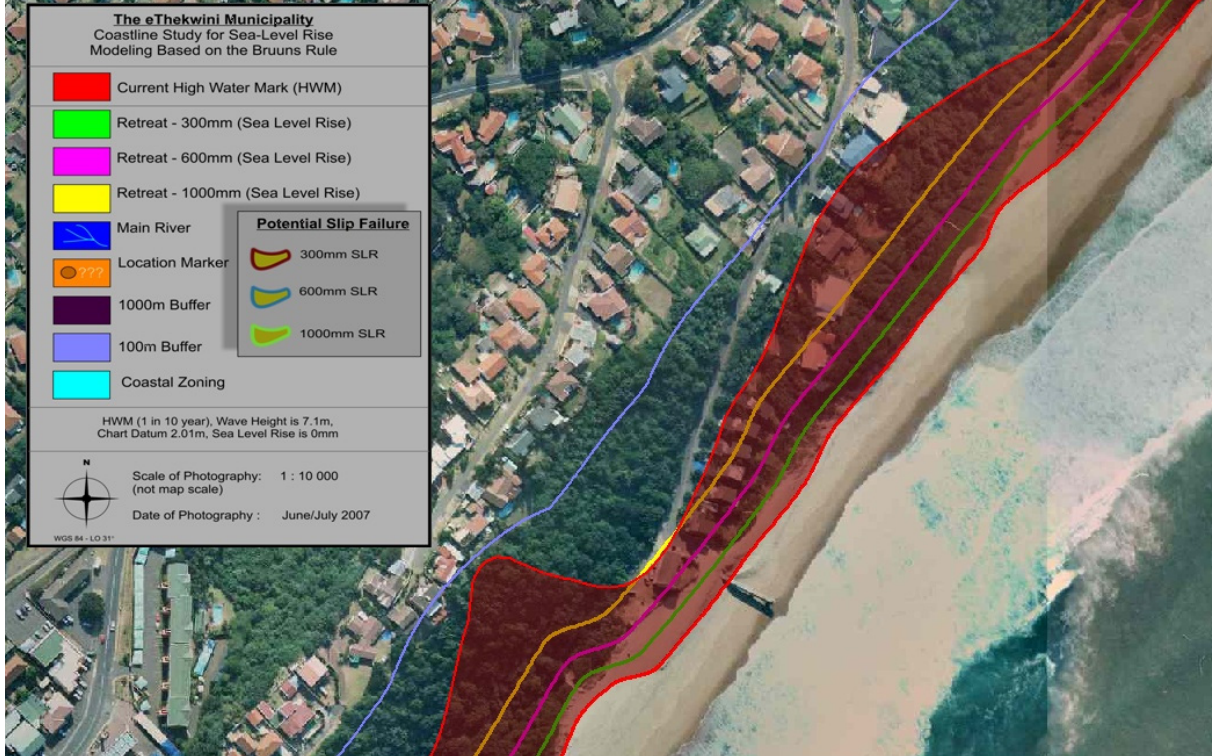
Figure 8. Slope failure of dunes with 1000 mm of sea level rise and loss of coastal forest